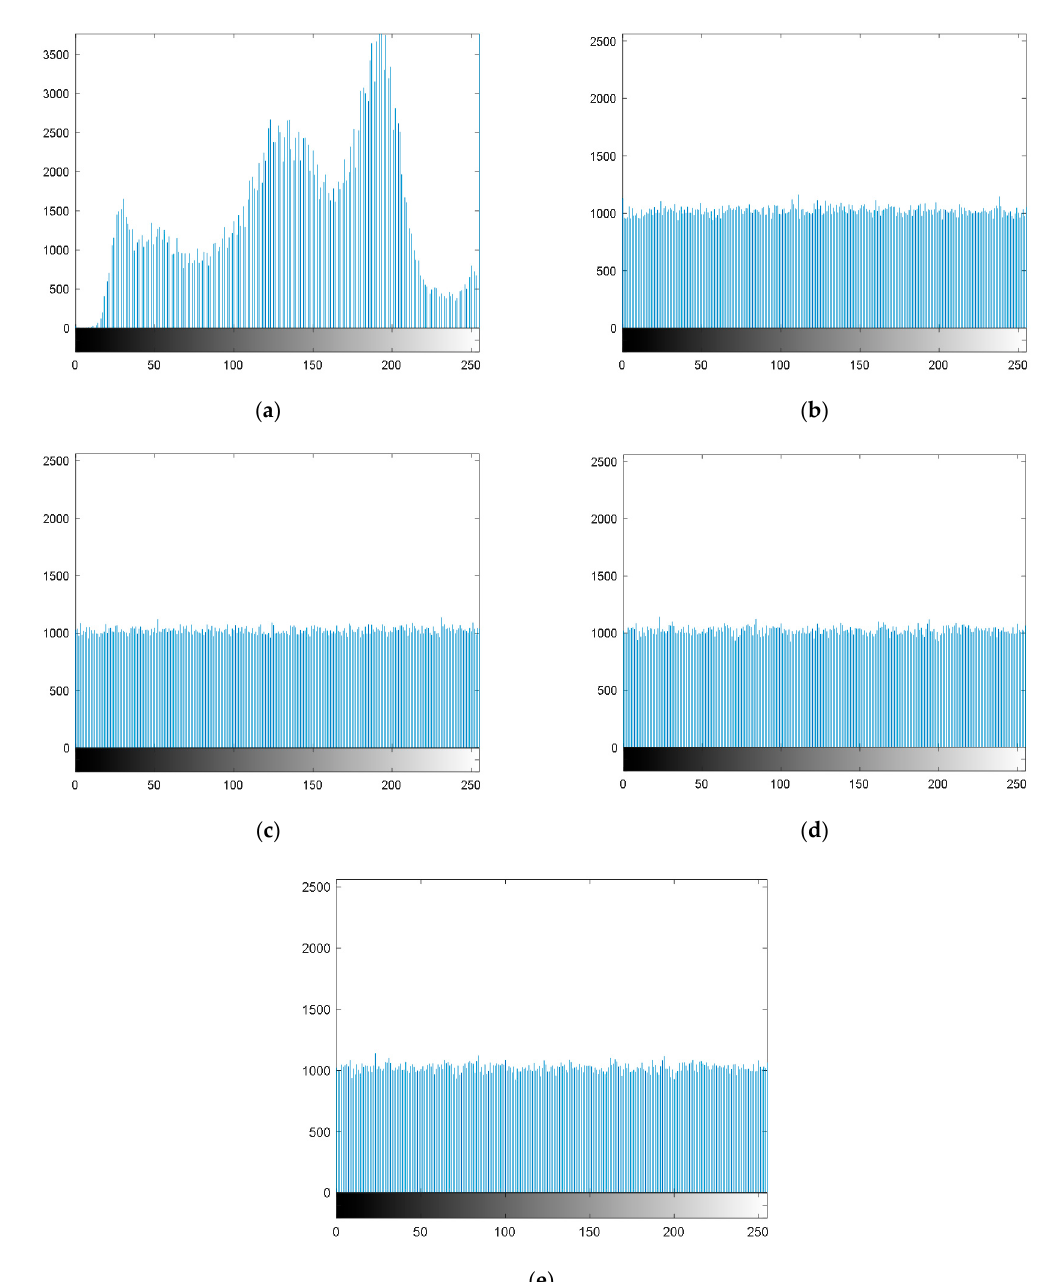
Figure 5. Histograms: ( a ) plain images; ( b ) encryption image of the proposed algorithm; ( c ) encryption image of Zhang’s algorithm; ( d ) encryption image of Kalubandi’s algorithm; and ( e ) encryption image of Hraoui’s algorithm.